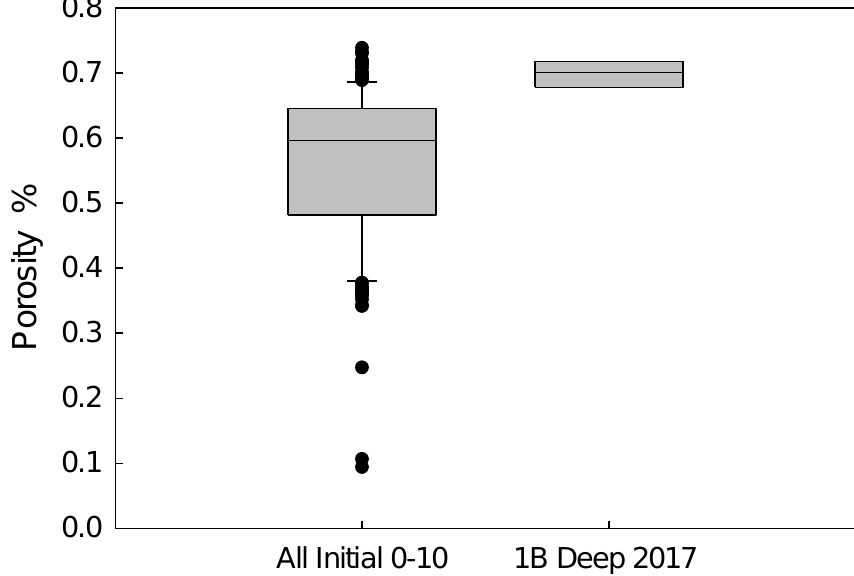
Figure 3. Box plot of sediment porosity data from initial characterization of all developed Poplar Island marsh cells (left, 0 – 10 cm depth, n = 174, mean ± s.d. = 0.56 ± 0.12), and increments from a single 0 – 200 cm core collected in Cell 1B in 2017 (right, n = 7, mean ± s.d. = 0.70 ± 0.02).